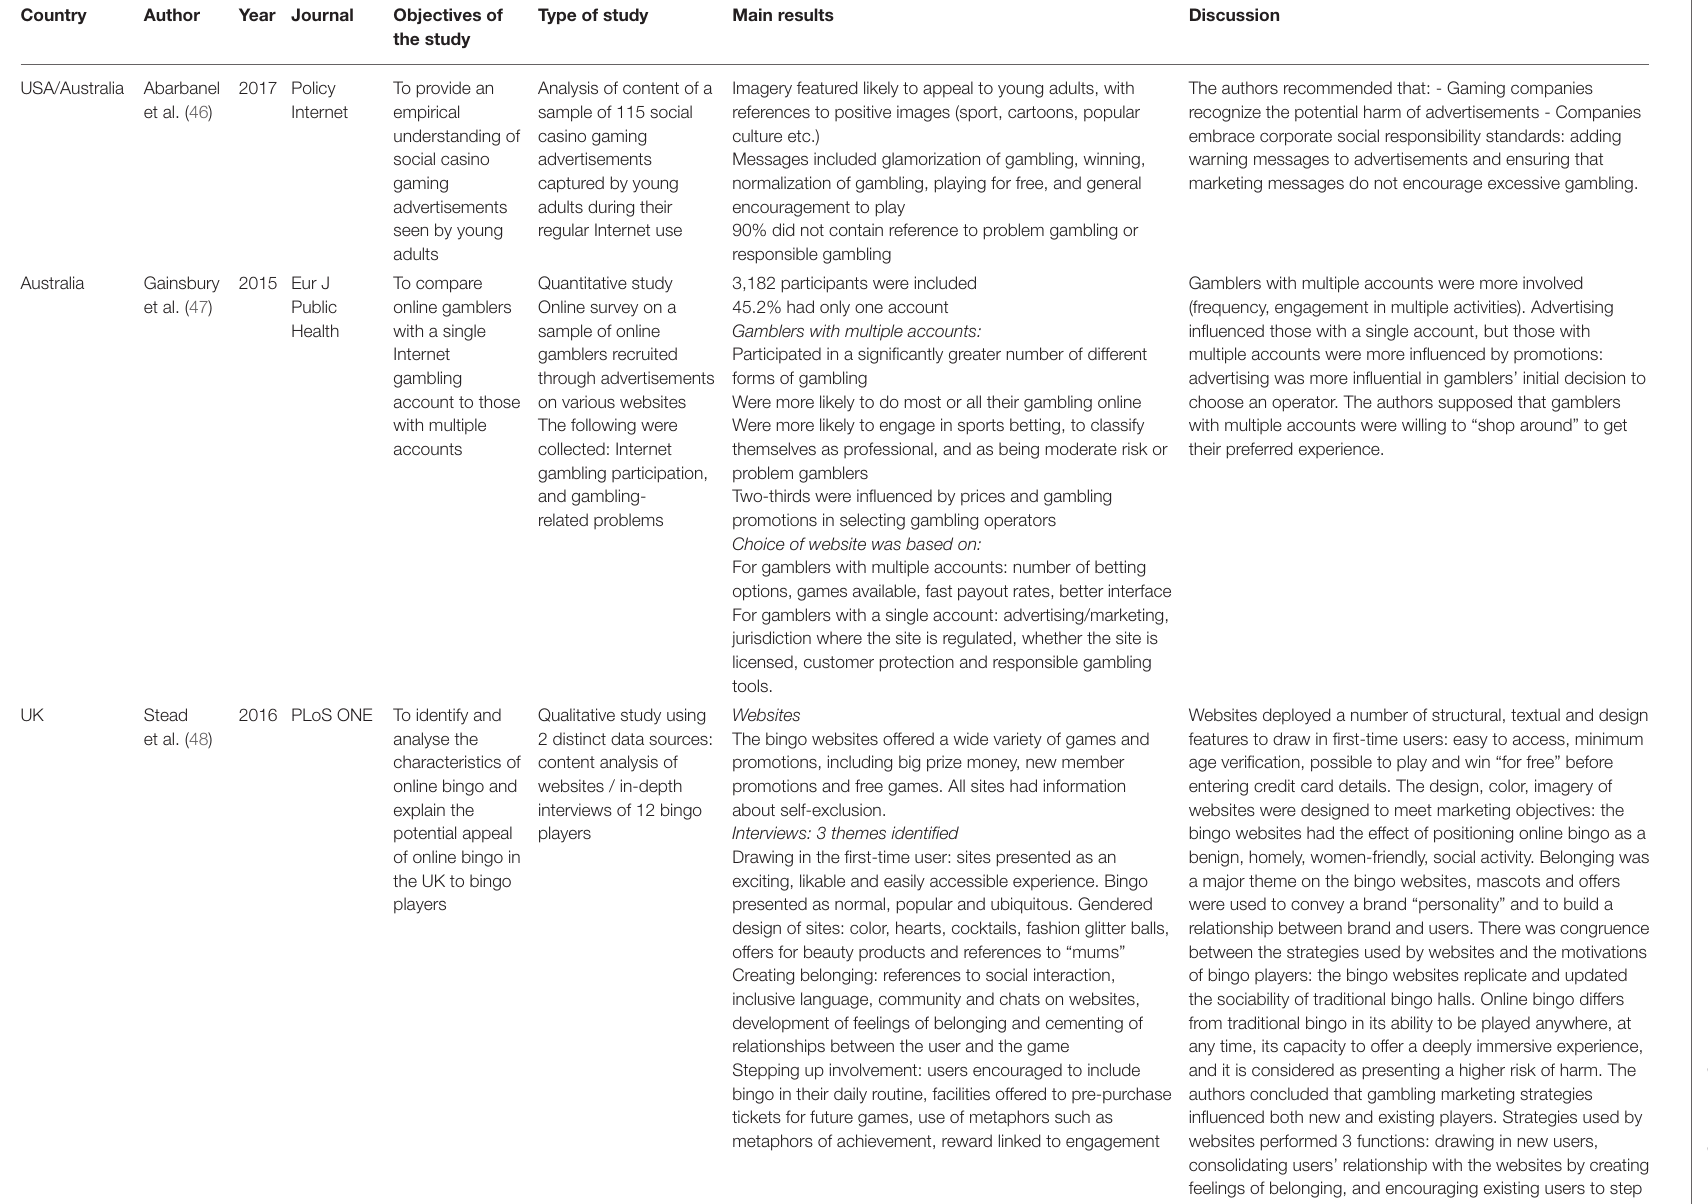
TABLE 2B | Articles concerning specific profiles (according gambling characteristics: type of game, numbers of